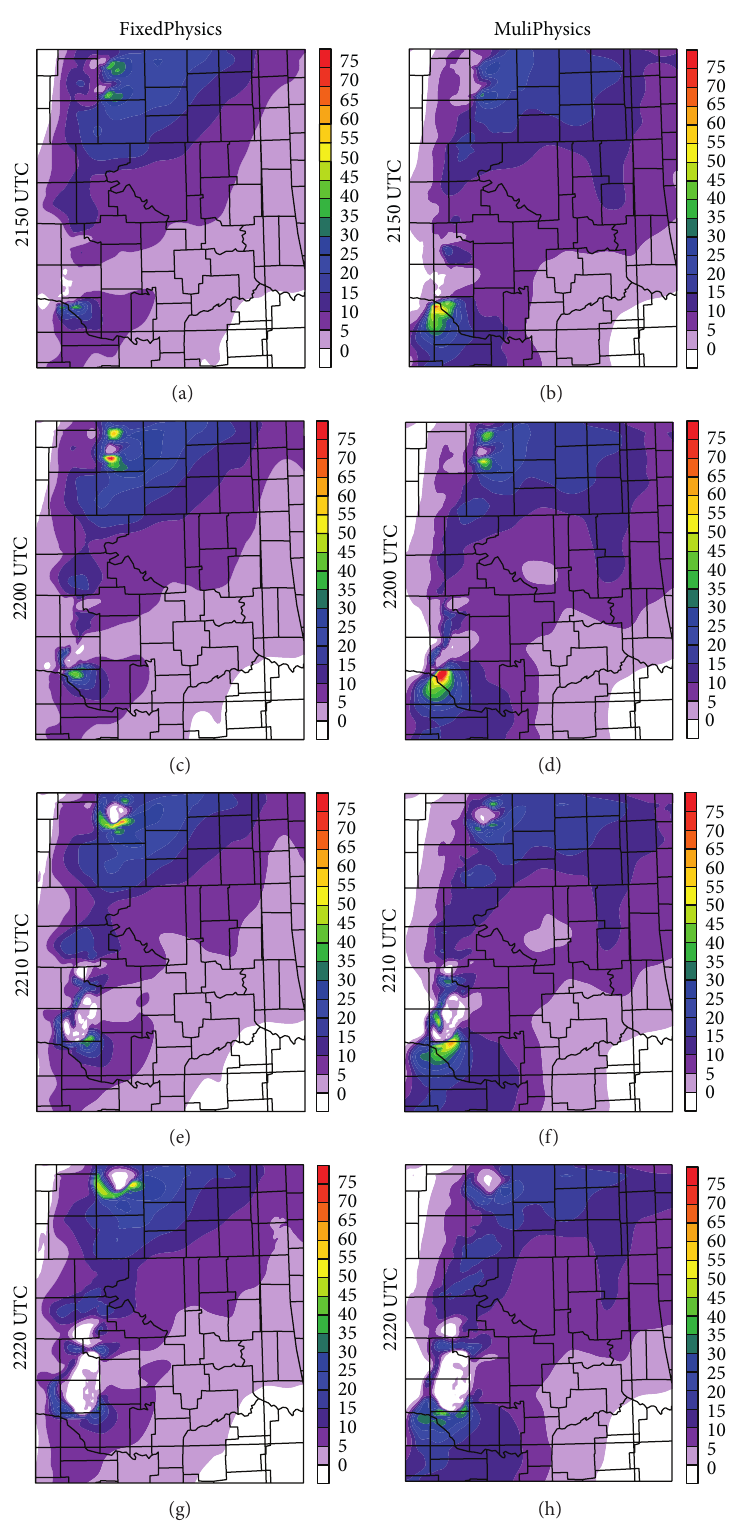
Figure 5: Ensemble-mean forecasts of STP parameter (colorfill, 5 increments) from FixedPhysics and MultiPhysics convective-scale experiments. The portion of the domain shown here is 306 × 363 km